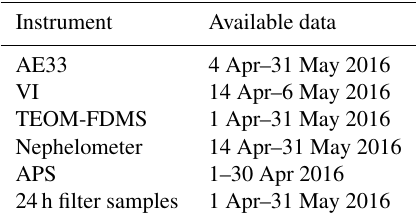
Table 1. Data coverage for online instrumentation and filter sam-